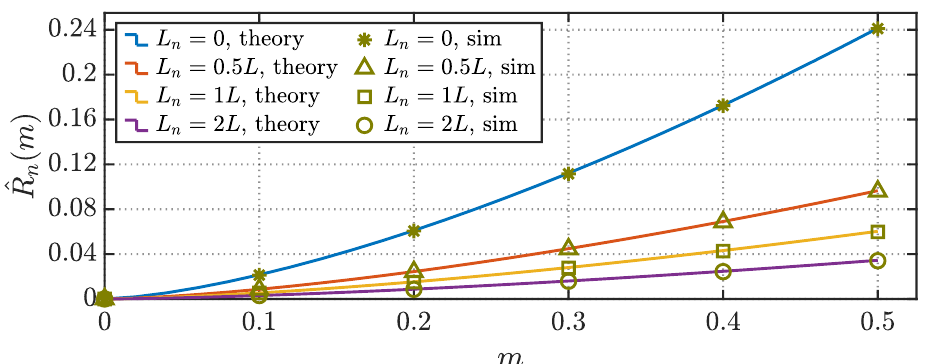
Figure 15. The normalized RMS value of the neutral switching current ripple as a function of modulation index m at specific inductance values of neutral line inductor.